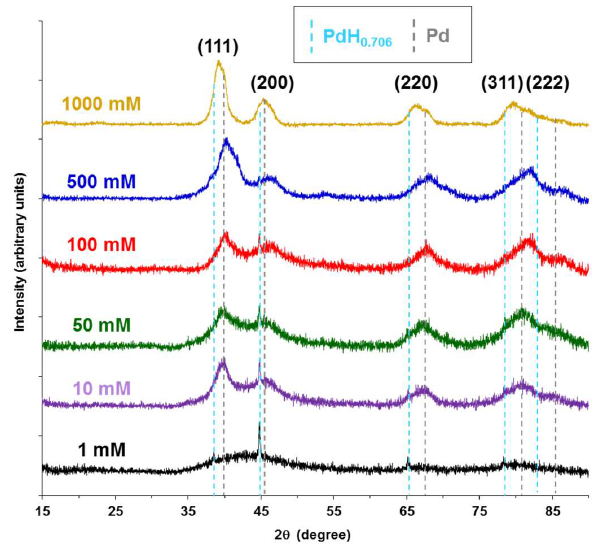
Figure 4. X-ray diffraction spectra for CNF-Pd composite aerogels synthesized from Pd(NH 3 ) 4 Cl 2 salt solution concentrations of 1 mM, 10 mM, 50 mM, 100 mM, 500 mM, and 1000 mM. JCPDS reference 00-018-0951 palladium hydride peak positions are indicated with a light blue dashed line, and dashed gray lines for 01-087-0643 palladium peak positions.